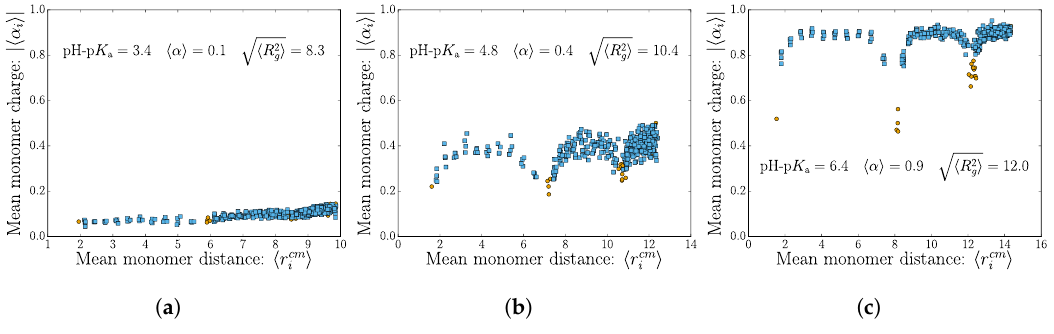
Figure 3. (Color online) The mean monomer dissociation state (cid:104) Σ i α i (cid:105) as a function of the mean distance to the nanogel center of mass. The different subplots ( a – c ) show an increasing value of the dissociation constant K a . The monomers belonging to a crosslink are colored in orange. All cases shown here have the same salt concentration of c s = 0.004